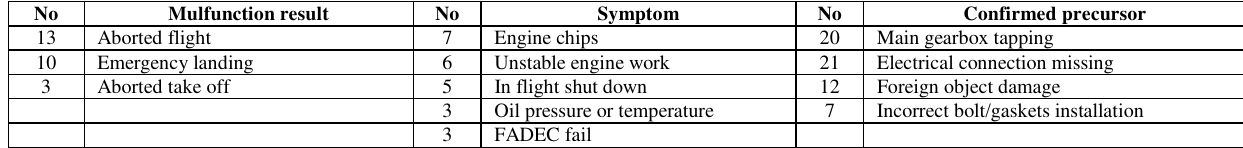
Table 14. Confirmed roots of the turboshaft engines failures which caused aviation